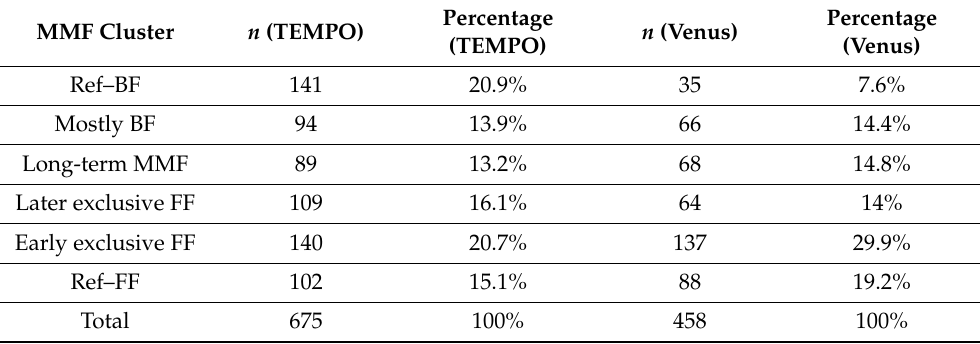
Figure 4. Feeding status trajectory for all MMF subjects in Venus per cluster. Each subject’s feeding pattern is represented by a horizontal line ranging from birth (leftmost) to 350 days of age (rightmost). The colour at each age describes whether the subject was exclusively BF, exclusively FF, or mixed feeding. The black dots indicate the recorded day of starting complementary feeding. Table 3. Size of the MMF clusters and reference groups in TEMPO and Venus, including the percent- age out of the total MMF and reference group